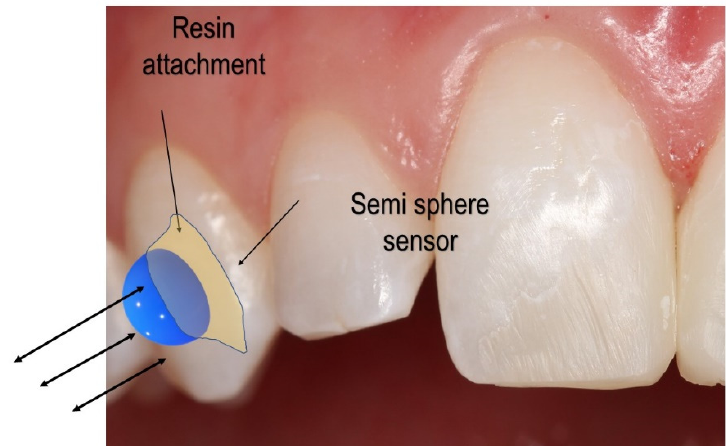
Figure 1. Proposed sensor placement over the